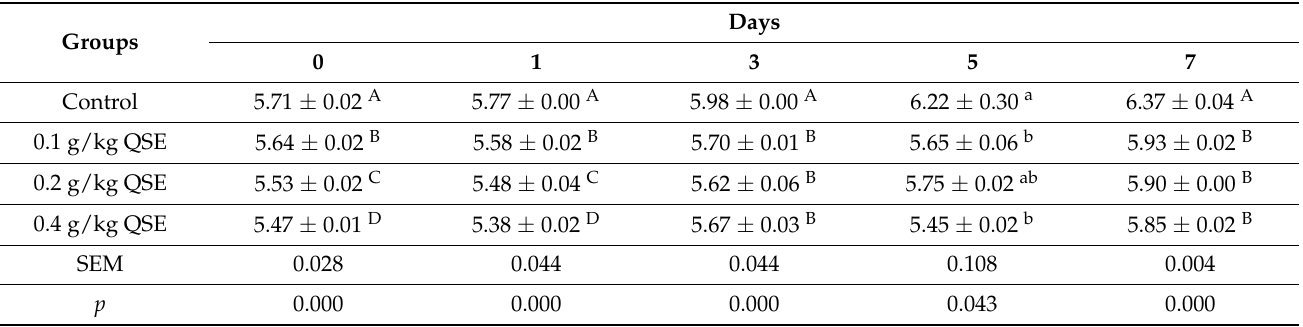
Table 12. Effect of storage on breast pH